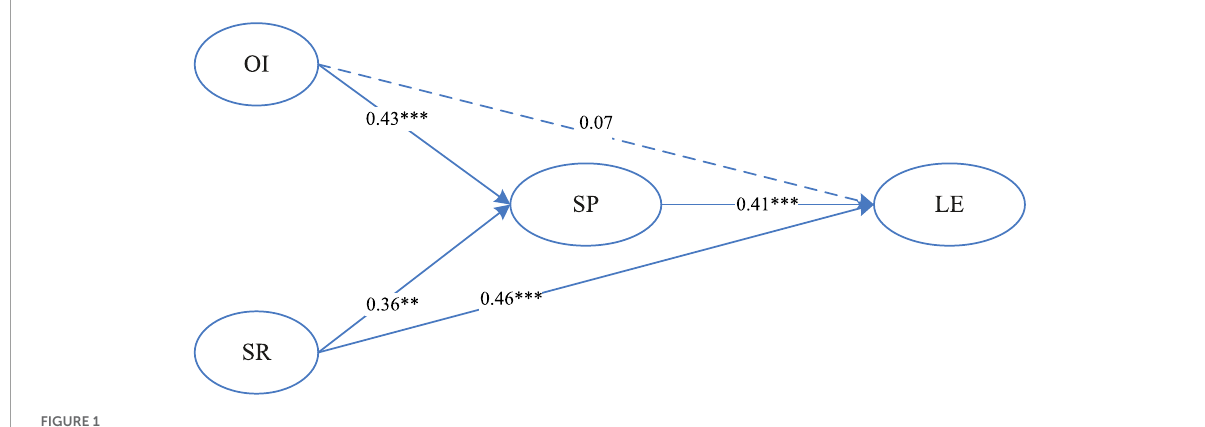
FIGURE1 Structural model of the associations among self-regulation and online interaction, social presence and learning engagement. ∗∗ p < 0.01, ∗∗∗ p < 0.001 ( χ 2 = 377.86, df = 127, CFI = 0.93, IFI = 0.93, TLI = 0.92, NFI = 0.90, RMSEA = 0.077).